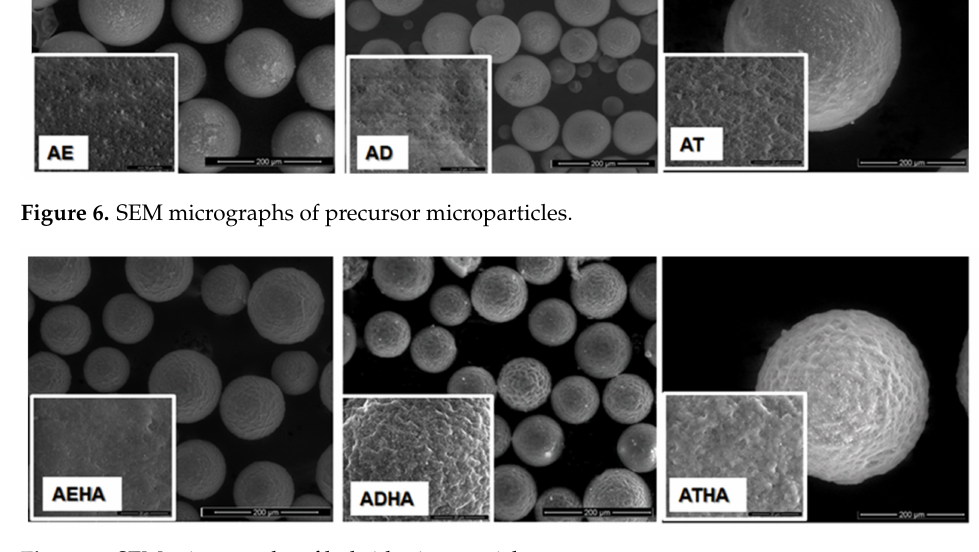
Figure 7. SEM micrographs of hybrid